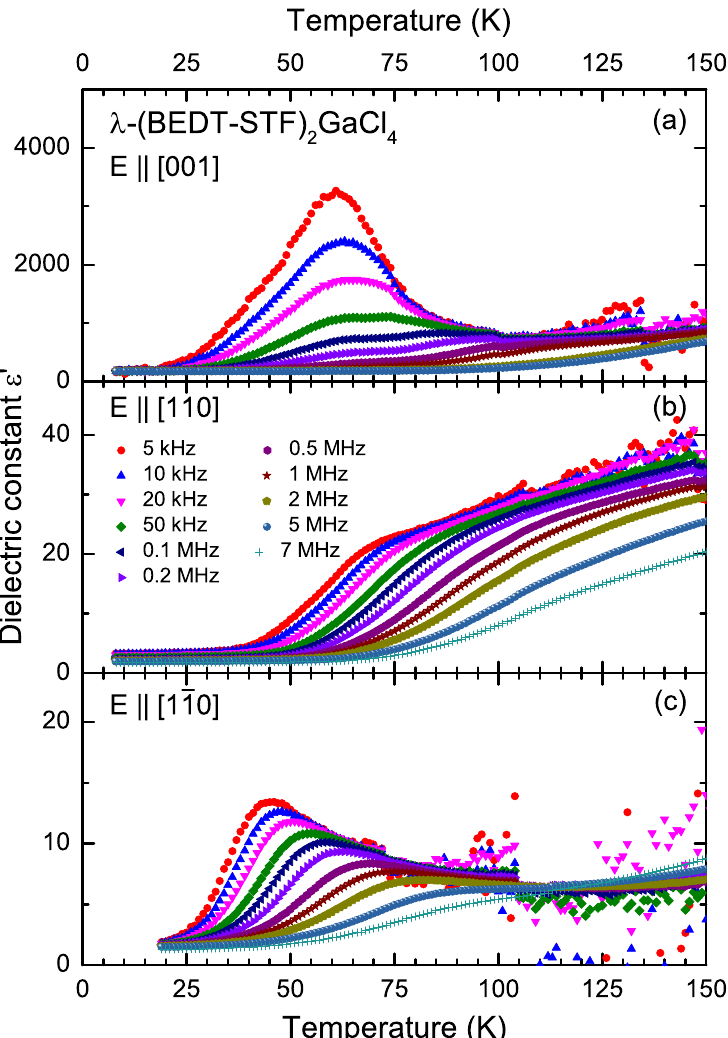
Figure 3. Temperature-dependent real part of the permittivity of λ -(BEDT-STF) 2 GaCl 4 recorded at different frequencies for the electric field along the three different directions, i.e., ( a ) E (cid:107) [ 001 ] , ( b ) E (cid:107) [ 110 ] , and ( c ) E (cid:107) [ 1¯10 ]